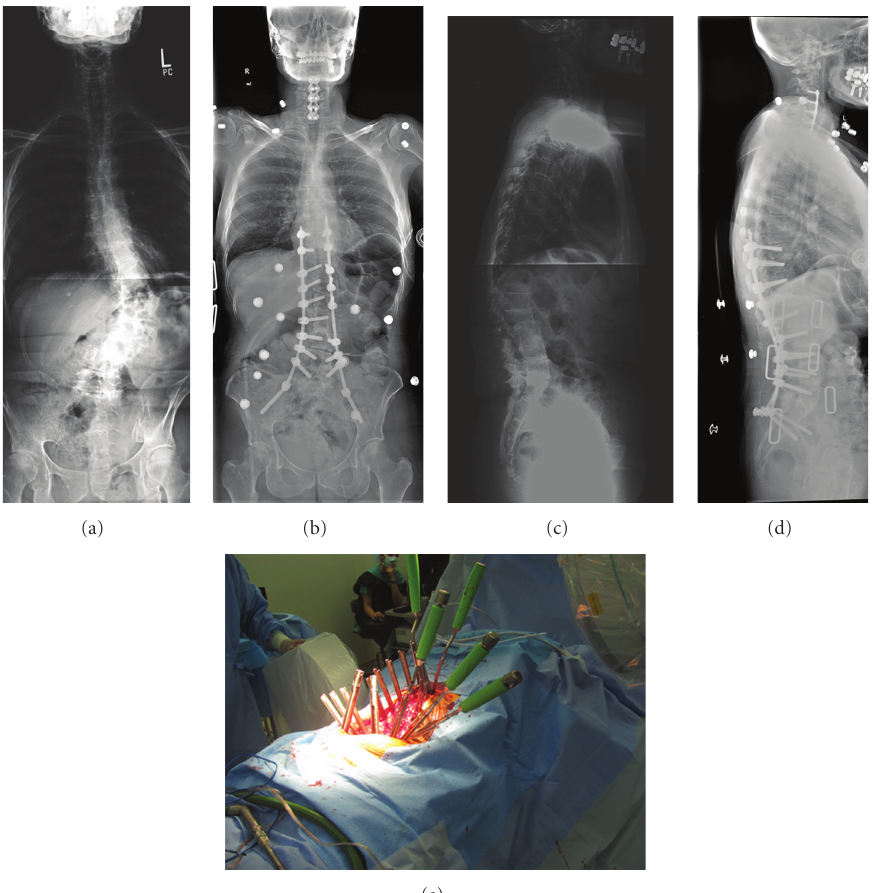
Figure 4: Case example showing a T9 to Iliac MIS fusion with interbody grafts at L2-S1. (a) and (b) Pre- and postoperative AP, and (c) and (d) Pre- and postoperative lateral 36” X-Ray images. (e) Intraoperative